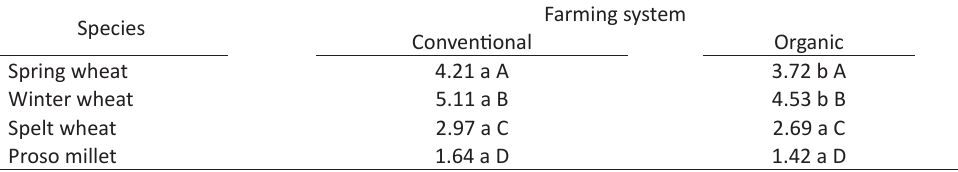
Table 7. Cereal grain yield (t ha -1 ) —mean for